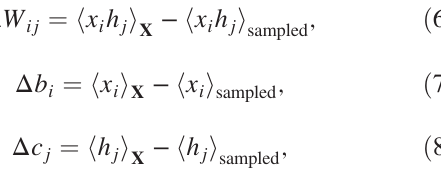
Z ½ W; θ (cid:2) ¼